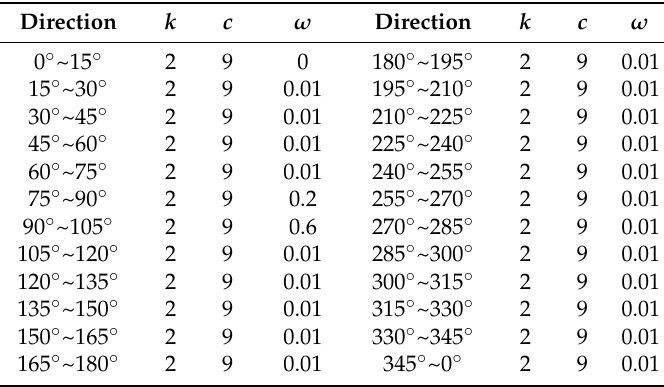
Table 2. Detail of the Weibull distribution wind condition.